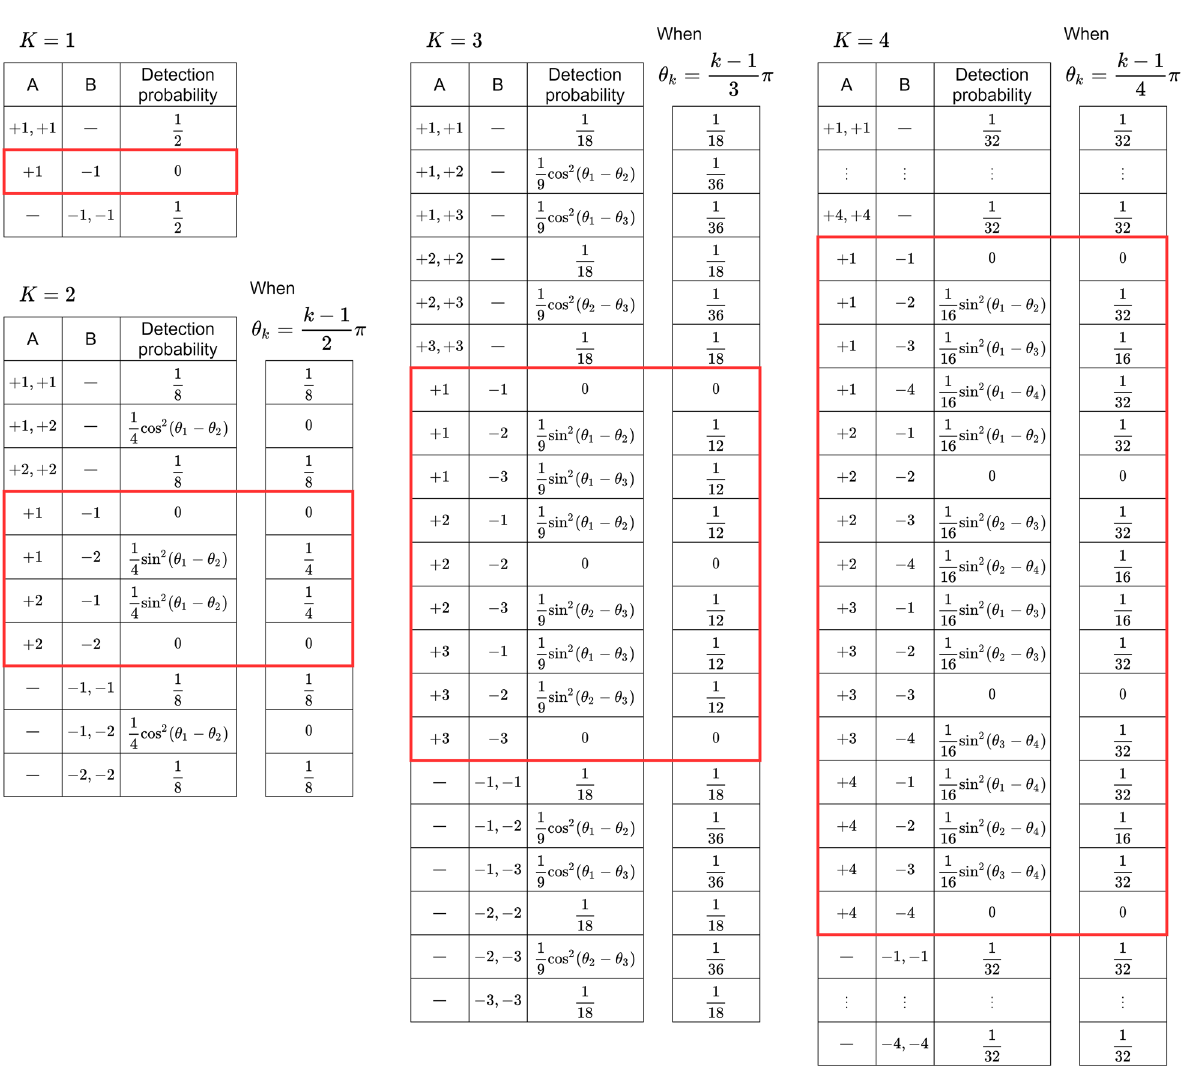
Figure 6. Probability of detecting certain OAM states at either sides of the beam splitter with K ranging from 1 to 4. The probability of a pair of photons being detected at different sides are marked by the red